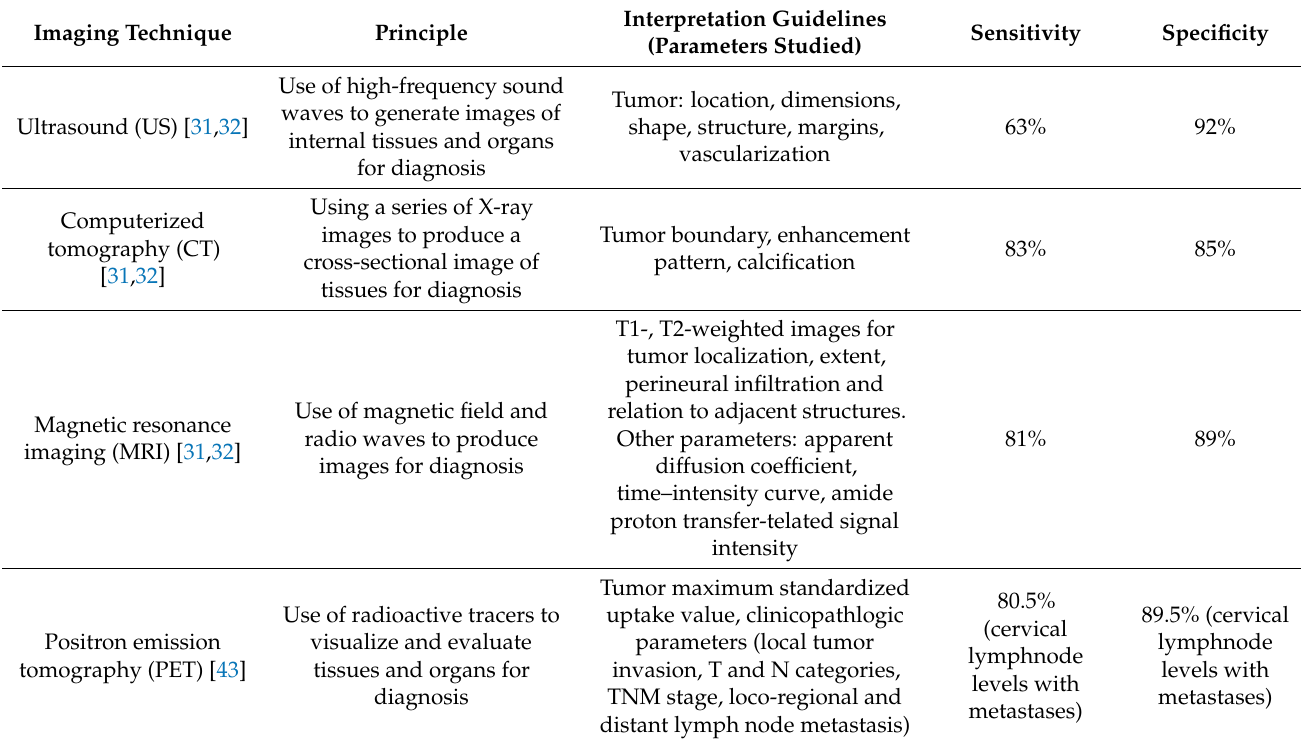
Table 3. Summary of diagnosing techniques and parameters